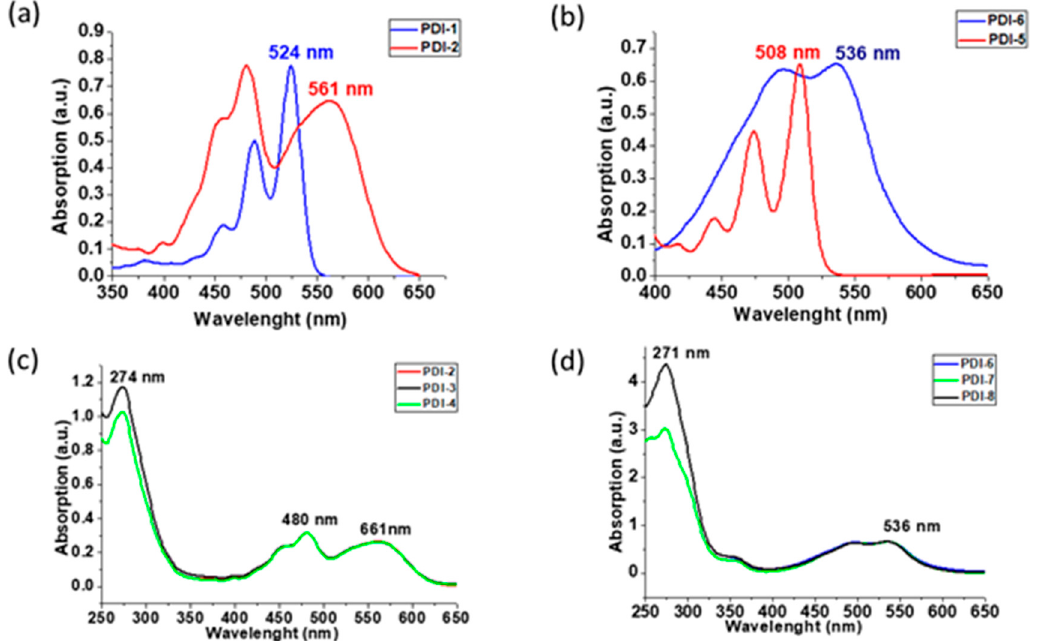
Figure 4. Normalized absorption in CHCl 3 as solvent at 25 °C of ( a ) PDI-1 and PDI-2 , ( b ) PDI-5 and PDI-6 , ( c ) PDI-2 , PDI-3 and PDI-4 , and ( d ) PDI-6 , PDI-7 and PDI-8 .